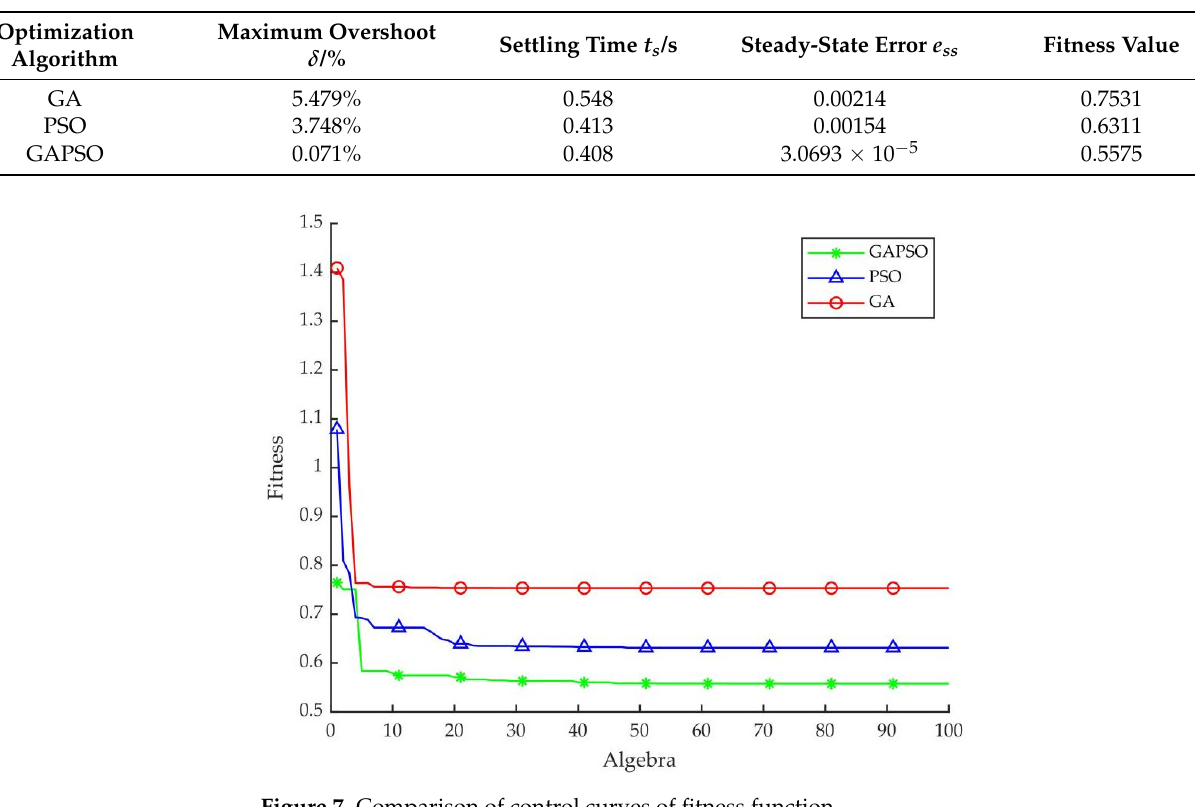
Table 3. Performance data sheet of simulation results.